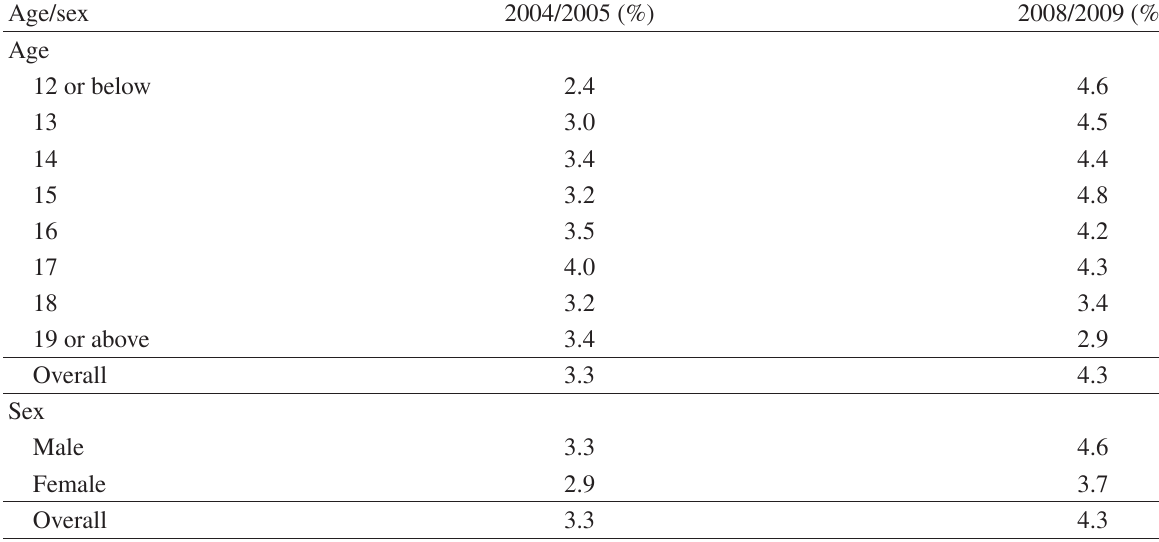
TABLE 3: Proportion of lifetime drug-taking students by age and by sex (Secondary Students) based on 2008/09 survey of drug use among students.